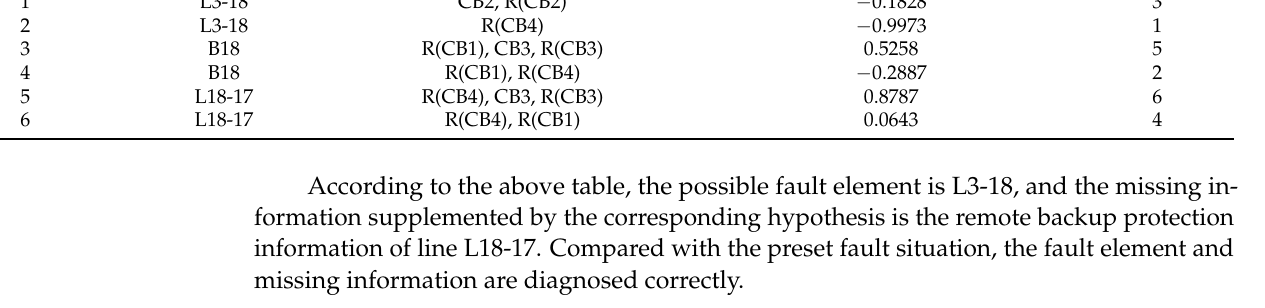
Figure 14. Fault area and circuit breaker state diagram.